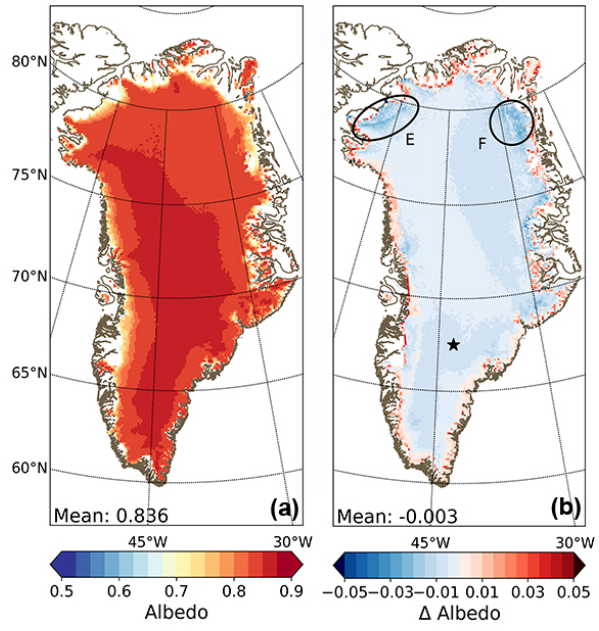
Figure 6. (a) Average 16d running mean total-sky RACMO2.3p2 albedo and (b) the average albedo difference between RACMO2.3p3 and RACMO2.3p2, for 15:00UTC between 2006 and 2015, with positive differences indicating that the albedo of RACMO2.3p3 is larger than RACMO2.3p2. Extended evalua- tion is done for the enclosed regions of E and F and the grid point located at the star.